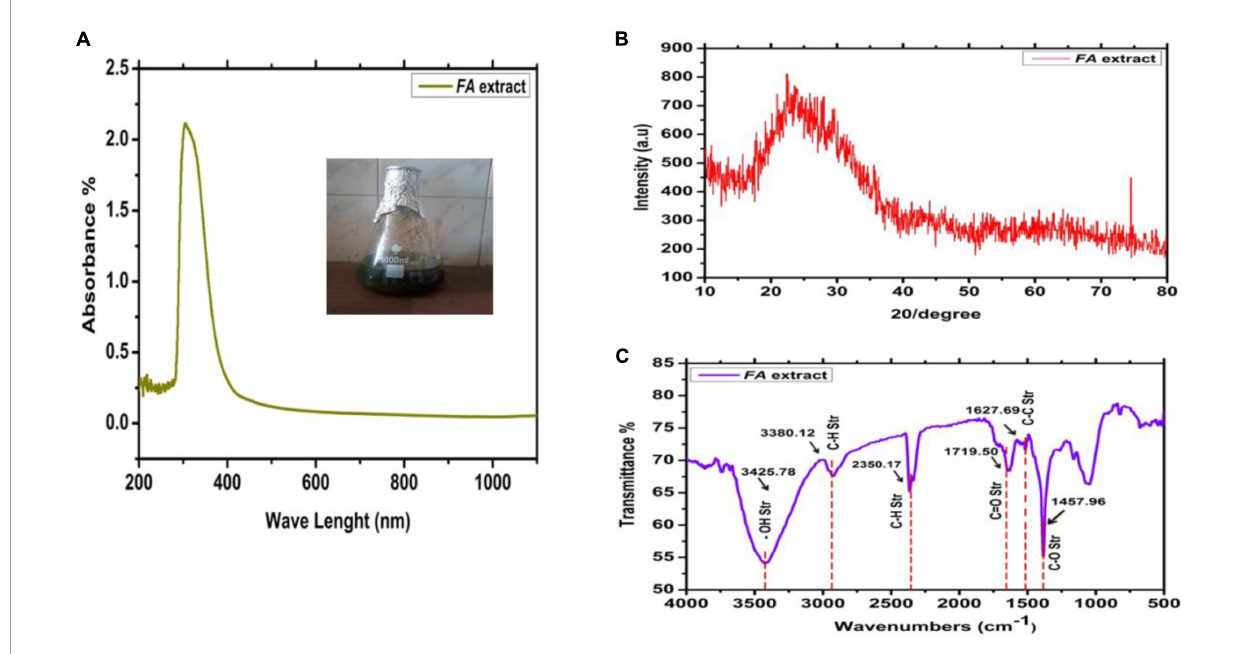
FIGURE2 Characterization of strawberry leaf extract. (A) UV-Visible ; (B) XRD; and (C)